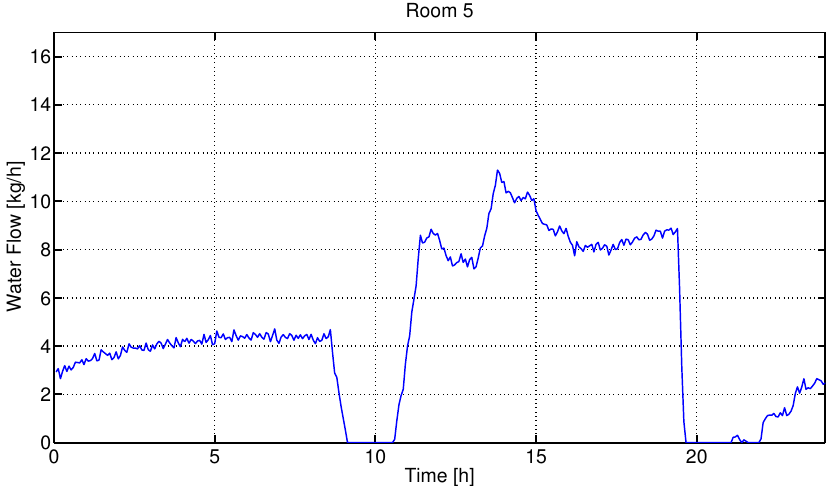
Figure 14. One day simulation (TRNSYS model), 5 December, for room 5 for the case of unoccupied rooms, case of radiators and ramp set-point